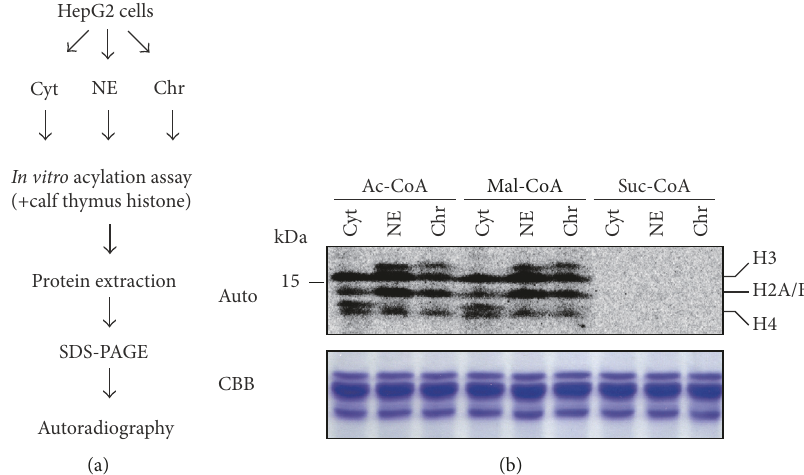
Figure 2: In vitro histone acylation assay using fractionated HepG2 cell extracts. (a) Schematic diagram of the fractionation of HepG2 cell extracts and in vitro acylation assay using calf thymus histone. (b) In vitro histone acylation assays using fractionated cell extracts. 14 C-labeled coenzyme A incorporation into histone proteins was assessed by autoradiography. The amounts of added substrate (calf thymus histone proteins) in each reaction were visualized by Coomassie Brilliant Blue (CBB). Molecular weights are indicated in the left side of the figure, and each histone position (histones H3, H2A/B, and H4) is indicated on the right side of the figure.